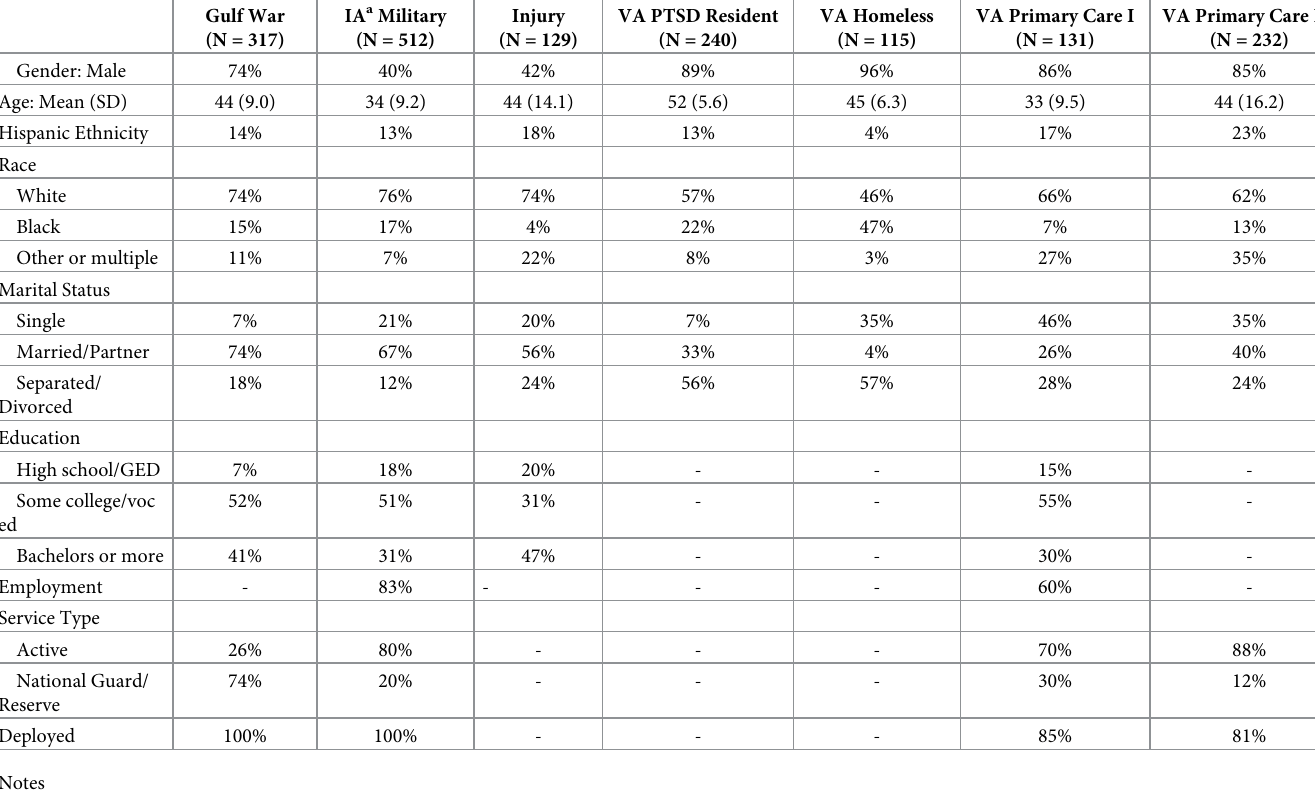
Table 1. Characteristics of the